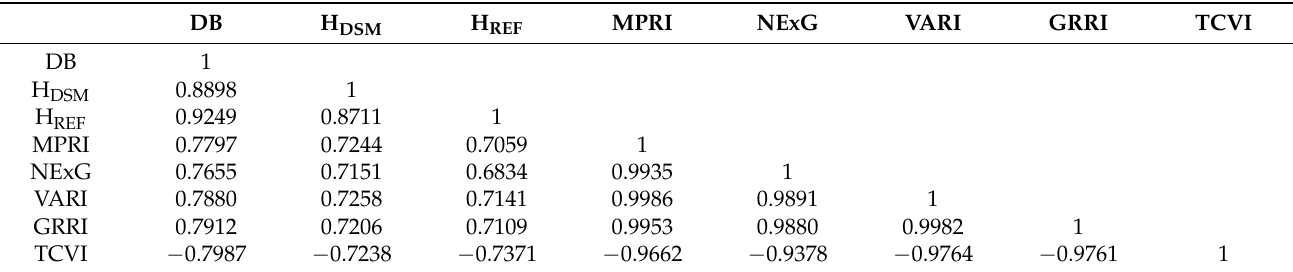
Table 7. Pearson’s correlation